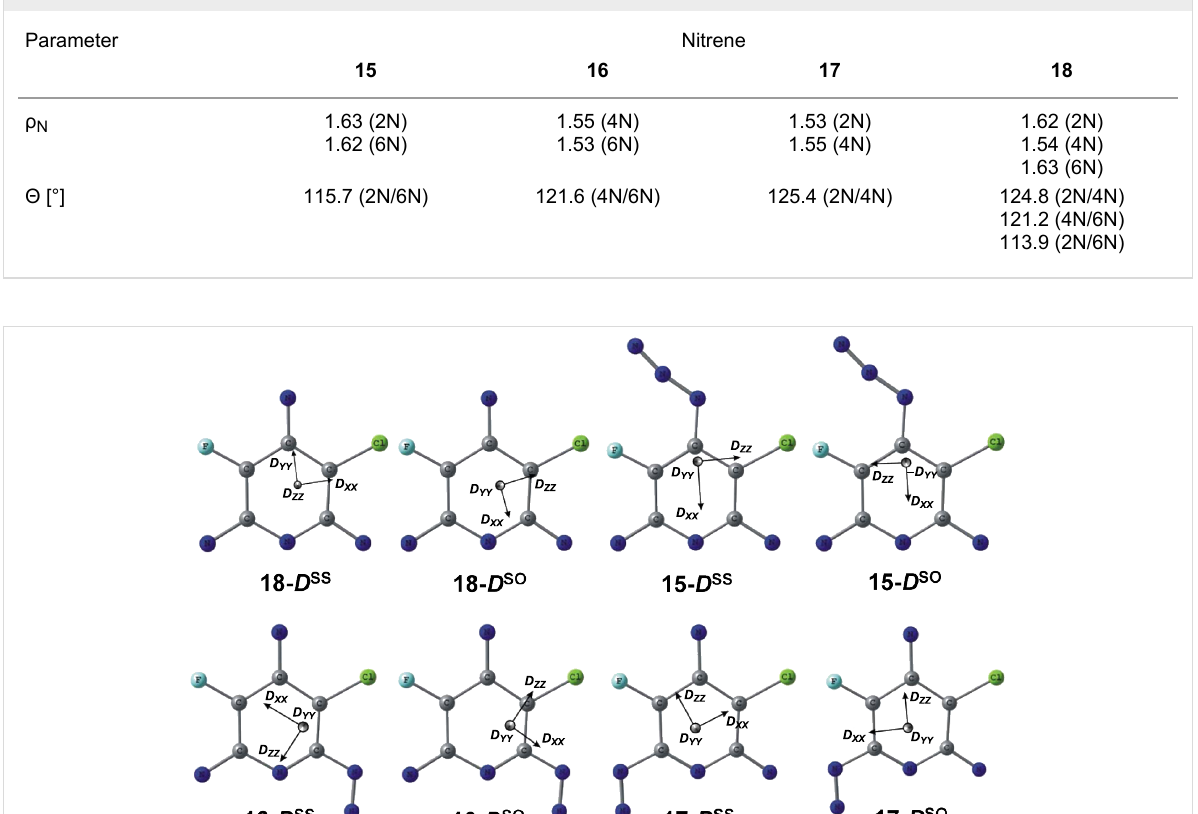
Table 1: Mulliken spin populations ρ N on the nitrene units and dipolar angles Θ between the nitrene C–N/C–N bonds in high-spin nitrenes 15 – 18 . Parameter